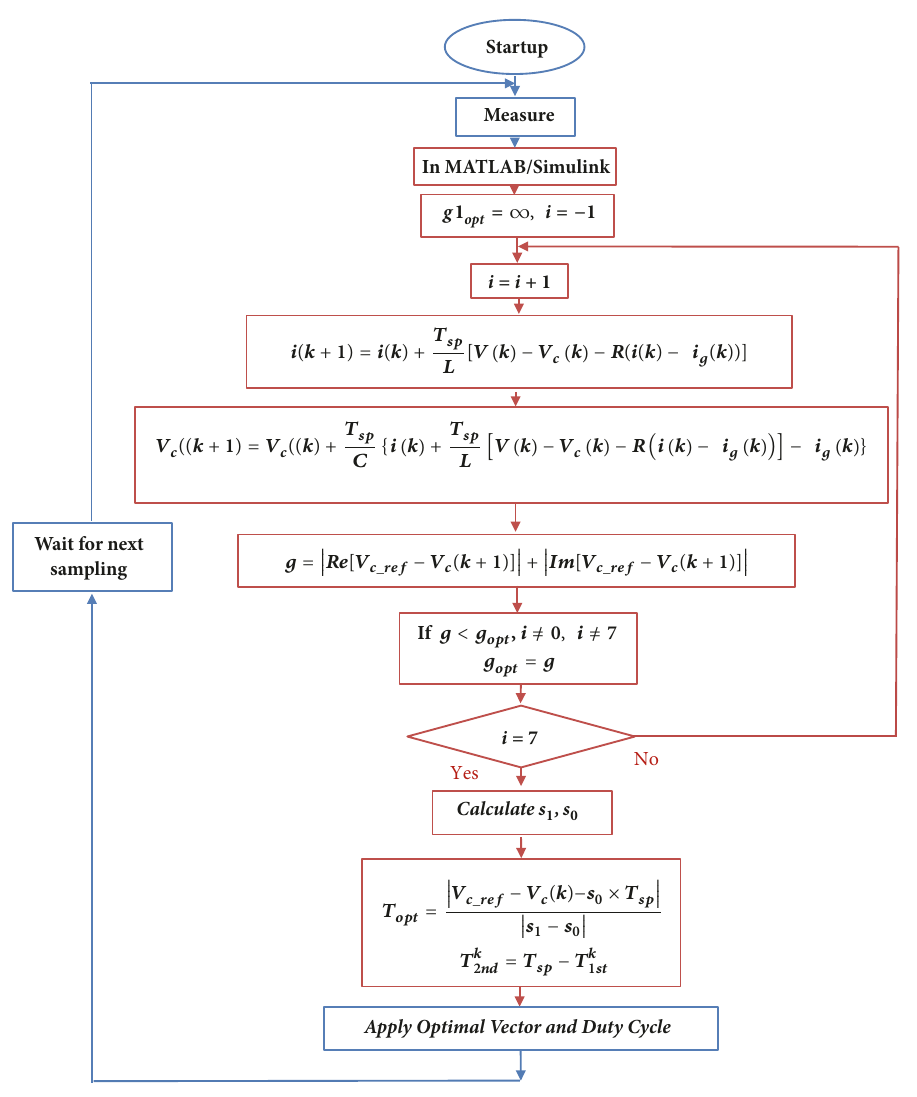
Figure 4: Flowchart of the proposed MPVC with duty cycle optimization.